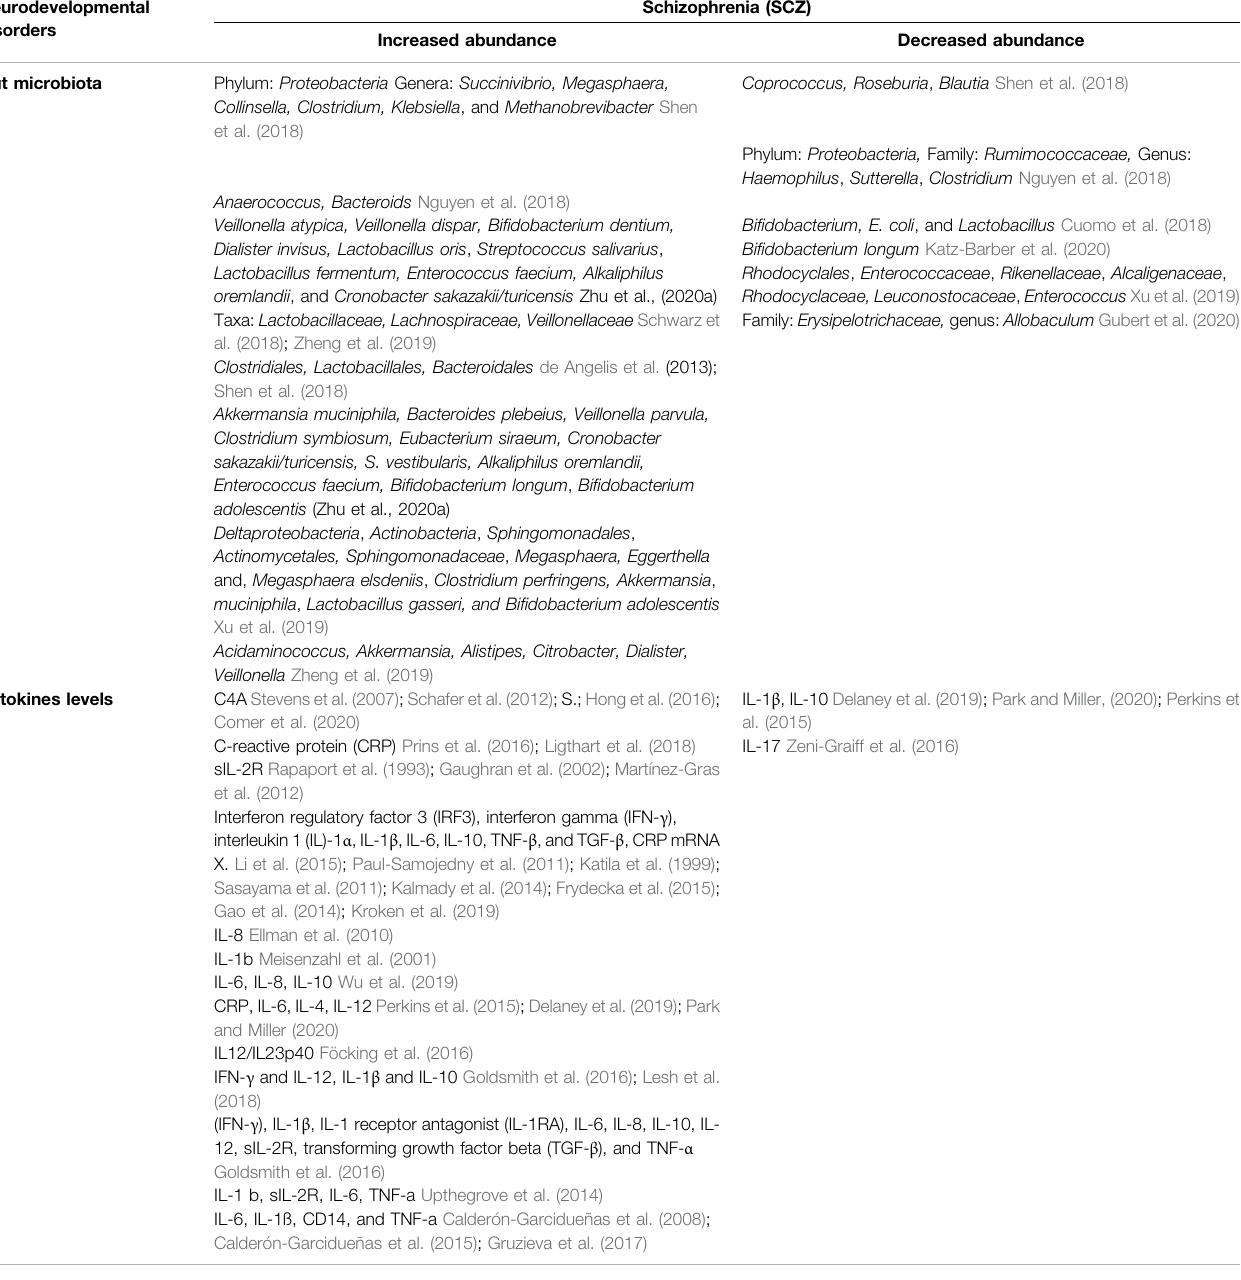
TABLE 3 | Gut microbes and Level of cytokines in Schizophrenia